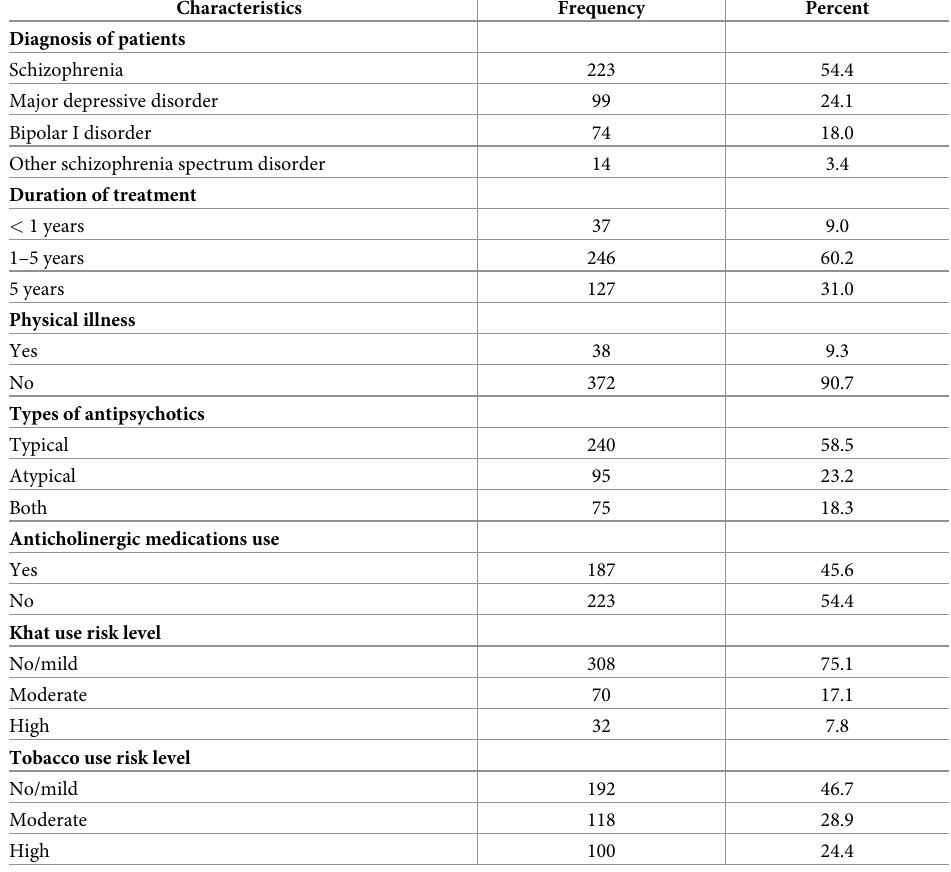
Table 2. Clinical, medication-related, and substance use risk levels of patients with mental illness attending fol- low-up treatment at JMC, 2019.